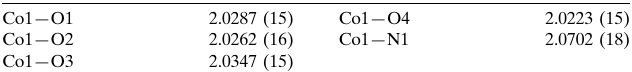
Selected bond lengths (A˚ ).